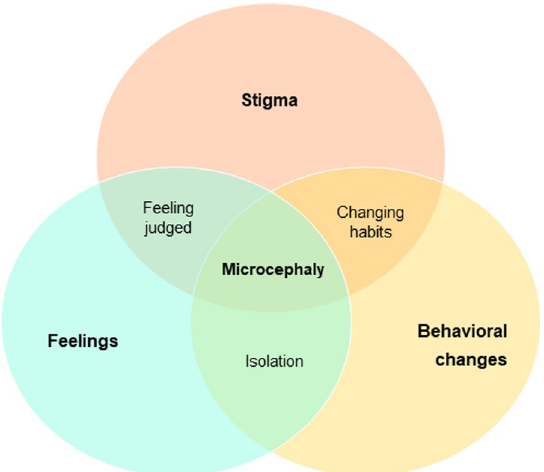
Fig 1. Cross-cutting issues of first-hand experiences of mothers of microcephalic children.